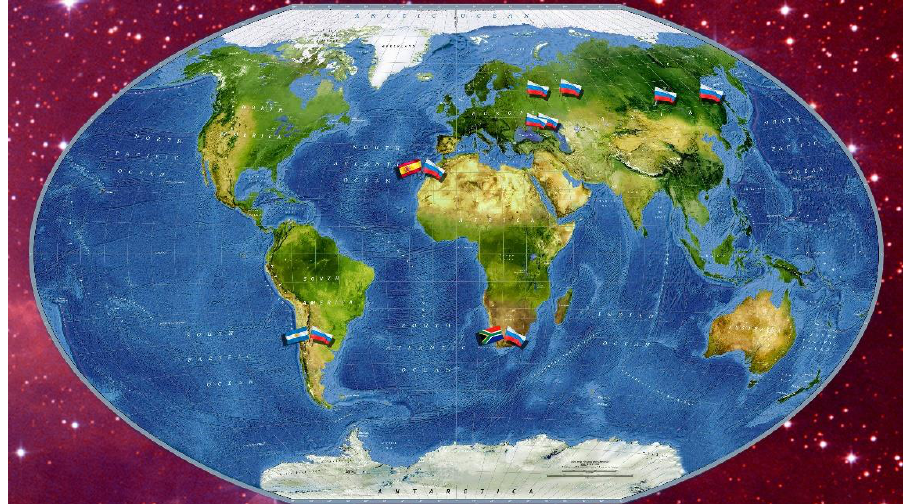
Figure 2. A sketch of the global MASTER robotic network for space monitoring. The facility locations of the corresponding participants are marked by flags on the map.